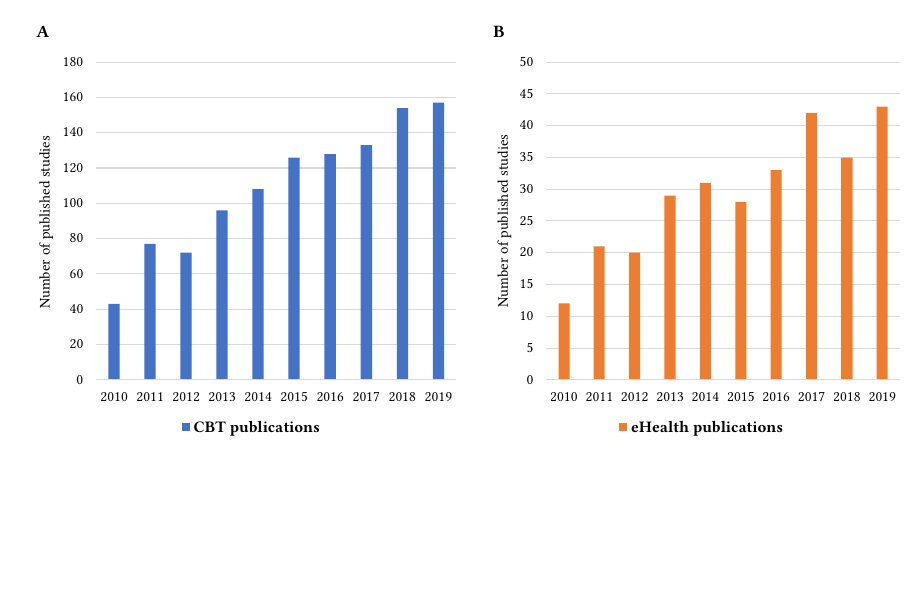
Frequency of Published Studies Including Treatment Arms Testing CBT Interventions (Figure 1A) and eHealth/ mHealth Interventions (Figure 1B) Per Year From 2010 to